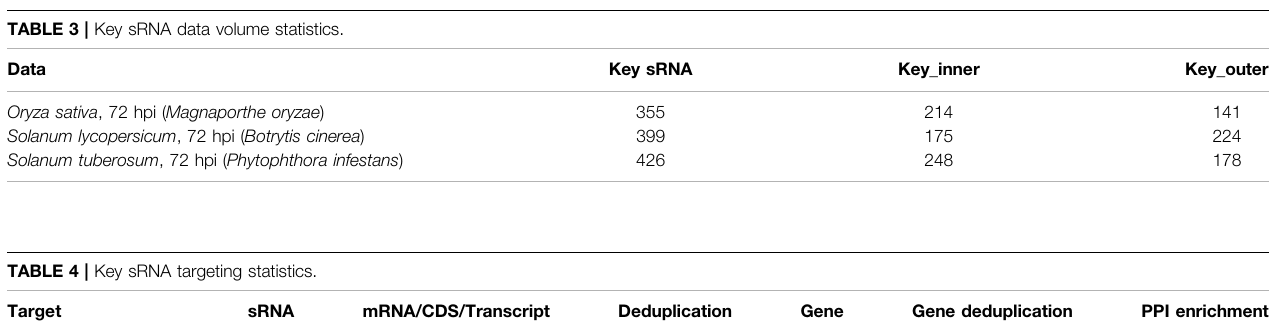
co-existing before and after Botrytis cinerea infects Solanum lycopersicum and the expression level of each sRNA. (C) shows the number of sRNA species co-existing before and after Phytophthora infestans infects Solanum tuberosum and the expression level of each sRNA.